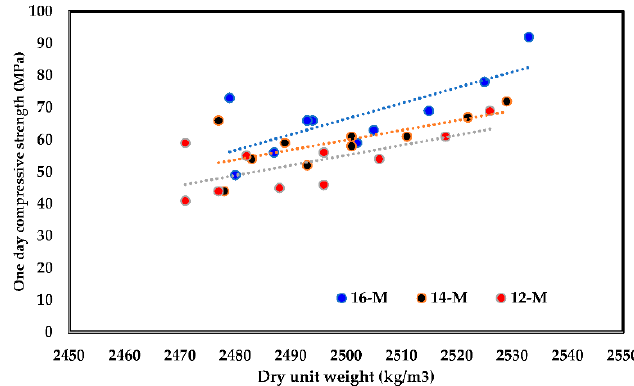
Figure 10. Relation between the CS and unit weight of at different KOH molarity under curing heat 60 °C.